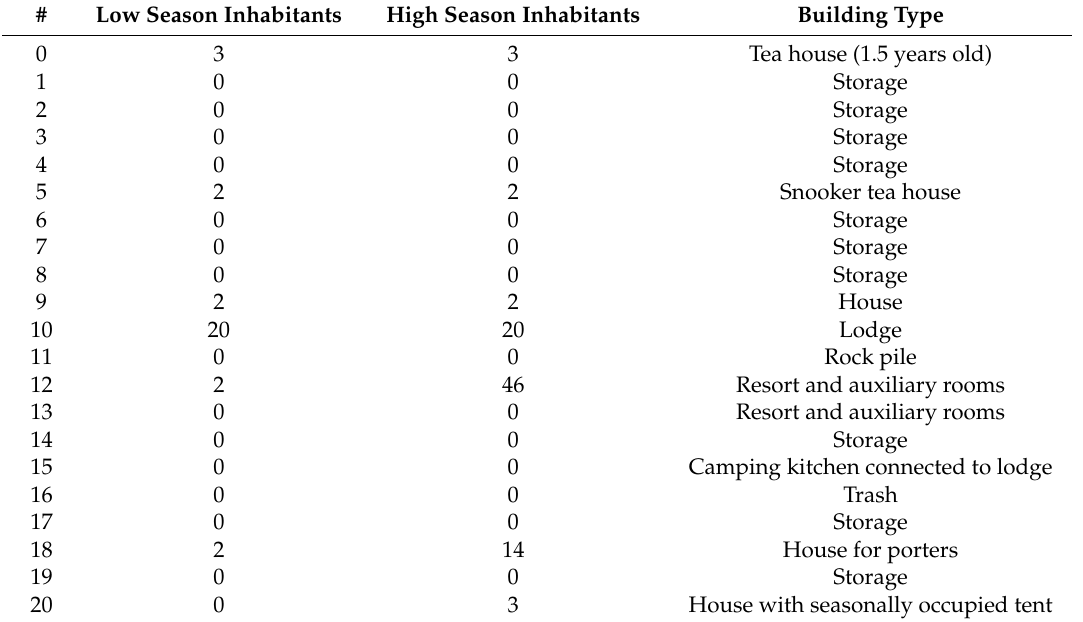
Table 4. Sample of infrastructure inventory data collected during field inventory in